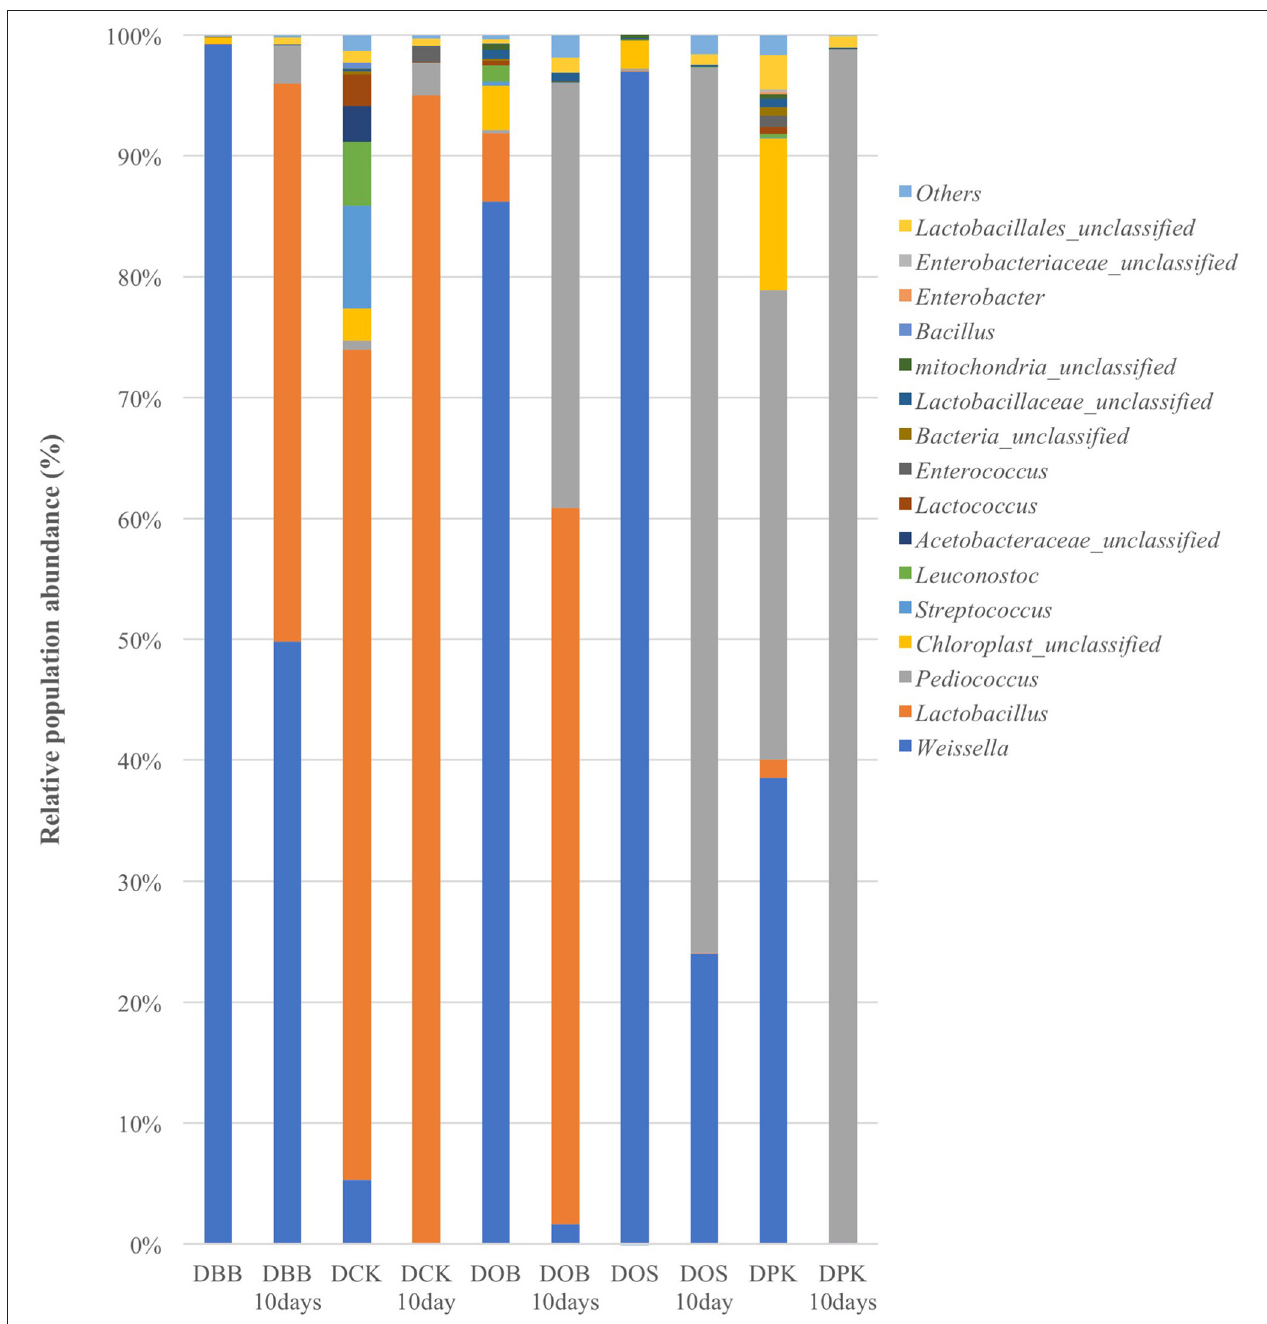
FIGURE 1 | Bacterial composition (OTUs at the genus level based on 16S amplicon sequencing) of the five starters and the corresponding microbial communities after 10 days of fermentation (labeled “10 Days”). DBB, DCK, DOB, DOS, and DPK are the five traditional Cambodian starters.